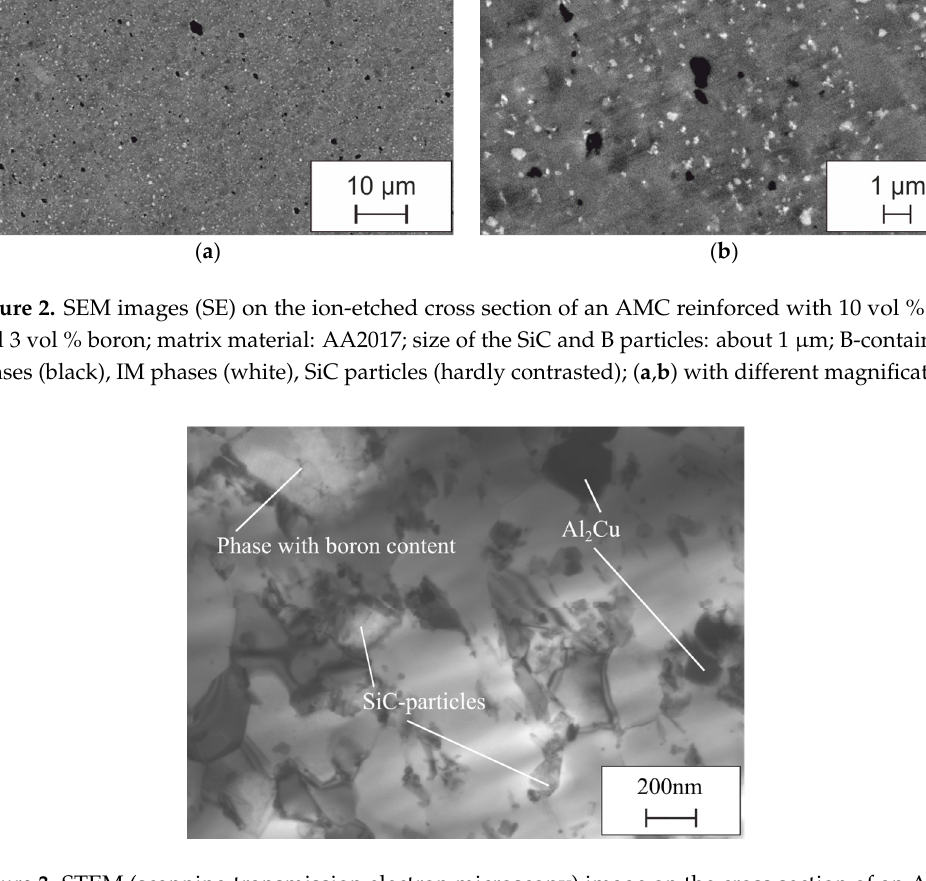
Figure 3. STEM (scanning transmission electron microscopy) image on the cross section of an AMC reinforced with 10 vol % SiC and 3 vol % boron.